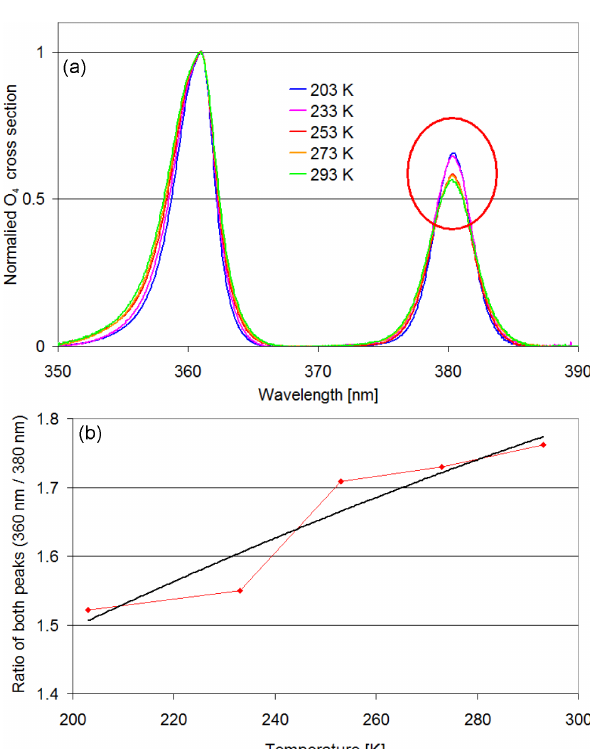
Figure A27. (a) Comparison of the O 4 cross sections from Thalman and Volkamer (2013) for different temperatures. The cross sections are divided by the maximum values at 360nm. After this normalisation, the resulting values at 380nm fall into two groups (high values for 203 and 233K, low values for 253, 273 and 293K). (b) Ratios of the peaks of the O 4 cross section at 360 and 380nm as a function of temperature (red points). The black curve is a fitted low-order